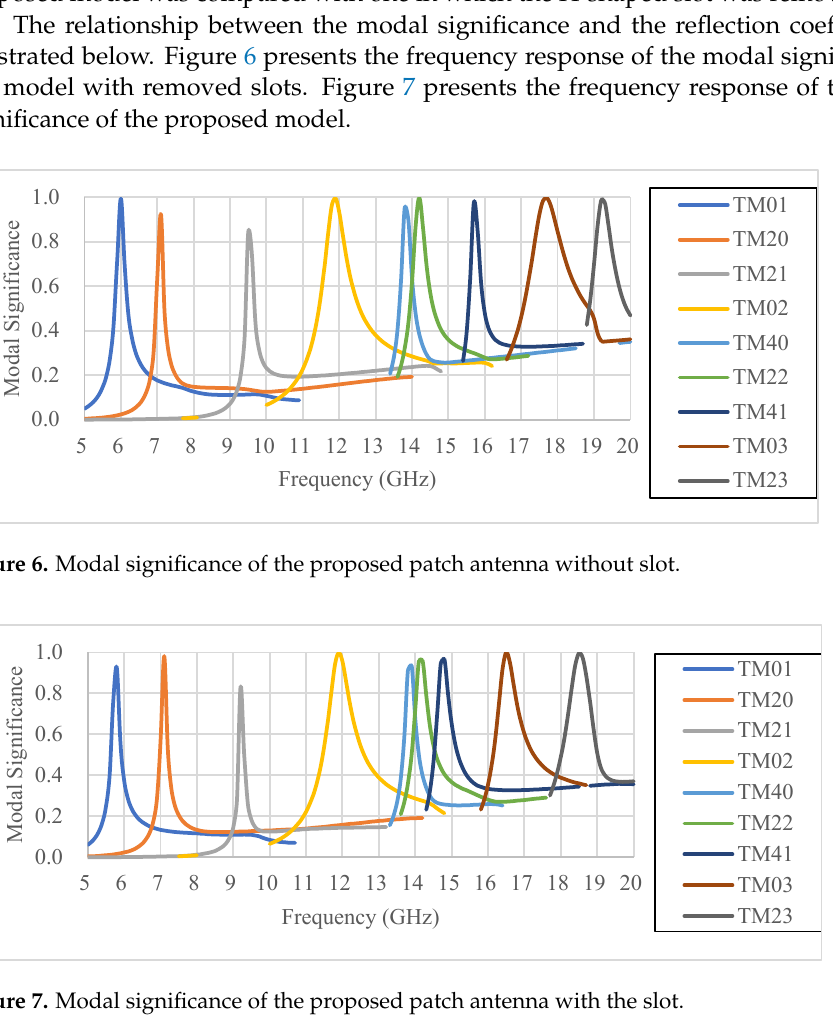
Figure 5. Current distribution of the proposed patch antenna. ( a ) Fundamental frequency. ( b ) Sec- ond-harmonic frequency. ( c ) Third-harmonic frequency.